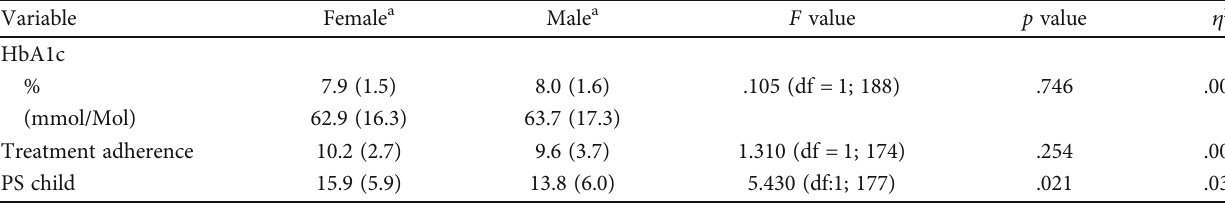
Table 2: Univariate ANOVAs for sex.